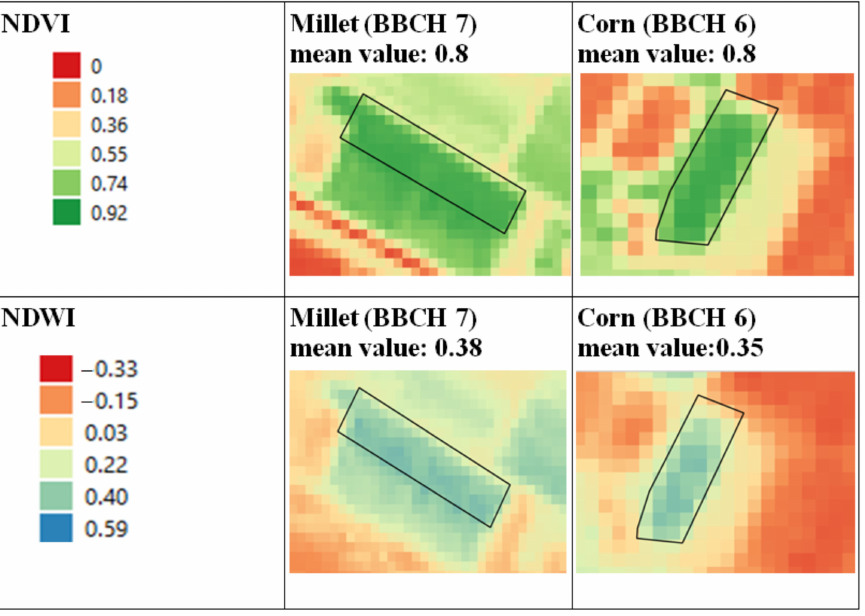
Figure 4. NDVI and NDWI indexes calculated on 5 July 2019 for millet (VM) and corn